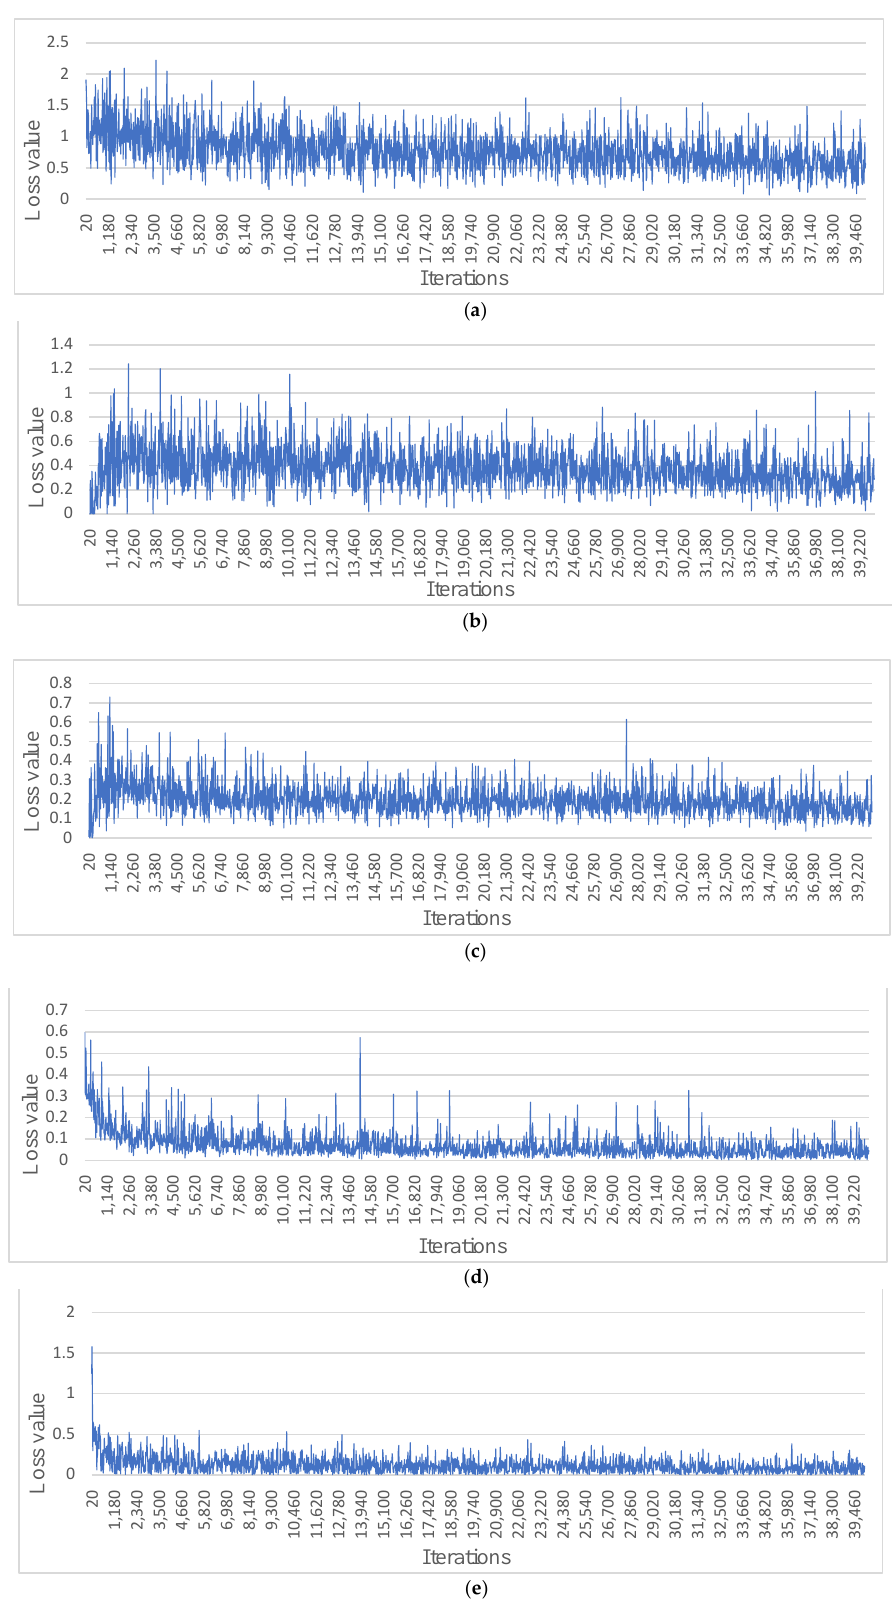
Figure 9. Faster R-CNN loss images. ( a ) Total loss. ( b ) Bounding box loss. ( c ) Classification loss. ( d ) Regional Proposal Network classification loss. ( e ) Regional Proposal Network bounding box loss.